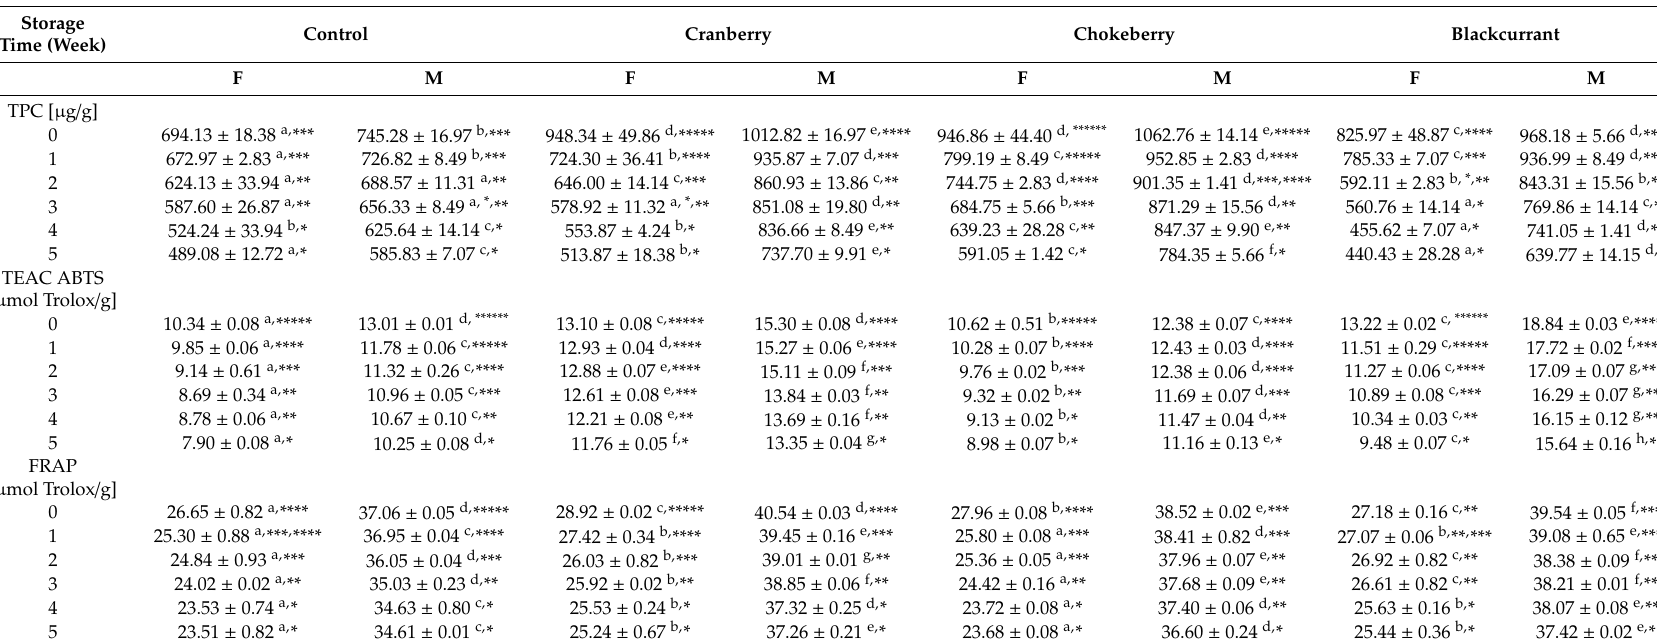
Table 3. Total polyphenols content (TPC) ( n = 2) and antioxidant capacity (Trolox equivalent antioxidant capacity (TEAC) ABTS and FRAP (Ferric